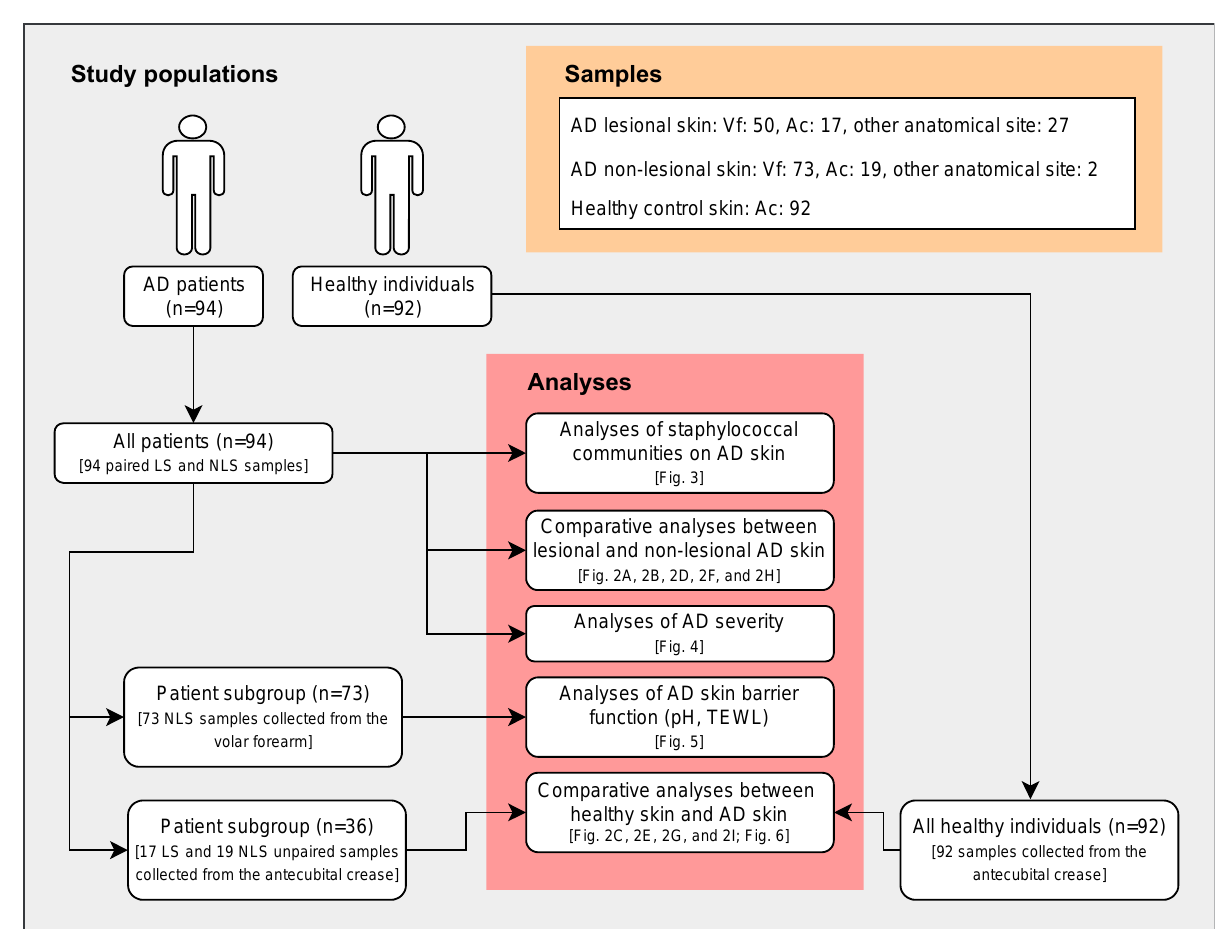
Figure 1. Study design. Illustration showing study subjects, samples, and performed analyses. Skin samples from healthy individuals were all collected at the antecubital crease. Consequently, only AD skin samples collected from the antecubital crease were included in comparative analyses between AD patients and healthy individuals. TEWL and pH were measured on the volar forearm on non-lesional AD skin, and only samples collected from this site were, therefore, included in analyses of skin barrier function. Abbreviations: AD: atopic dermatitis; LS: lesional skin; NLS: non-lesional skin; TEWL: transepidermal water loss; Vf: volar forearm; Ac: antecubital